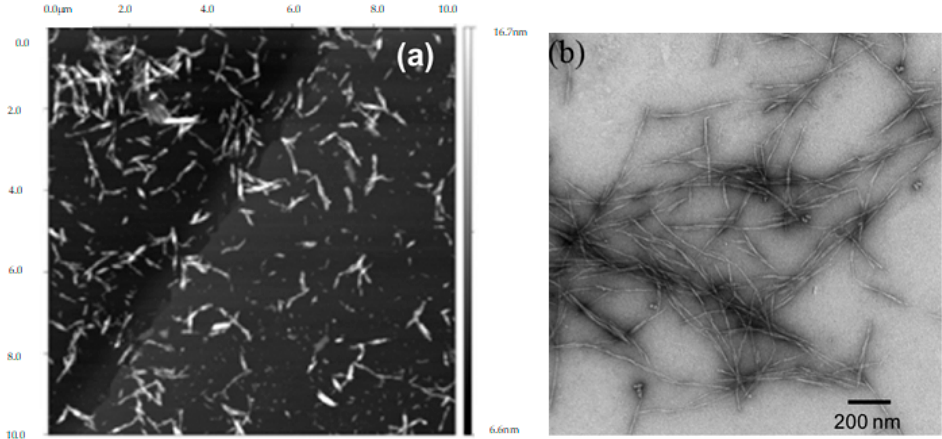
Figure 2. Images of cellulose nanocrystals (CNCs) by AFM (atomic force microscopy) ( a ) and cellulose nanofibrils (CNFs) by TEM (transmission electron microscopy) ( b ) obtained by enzymatic hydrolysis followed by mechanical treatment. Reprinted from [35] and [36], respectively, Copyright (2020), with permission from Elsevier.